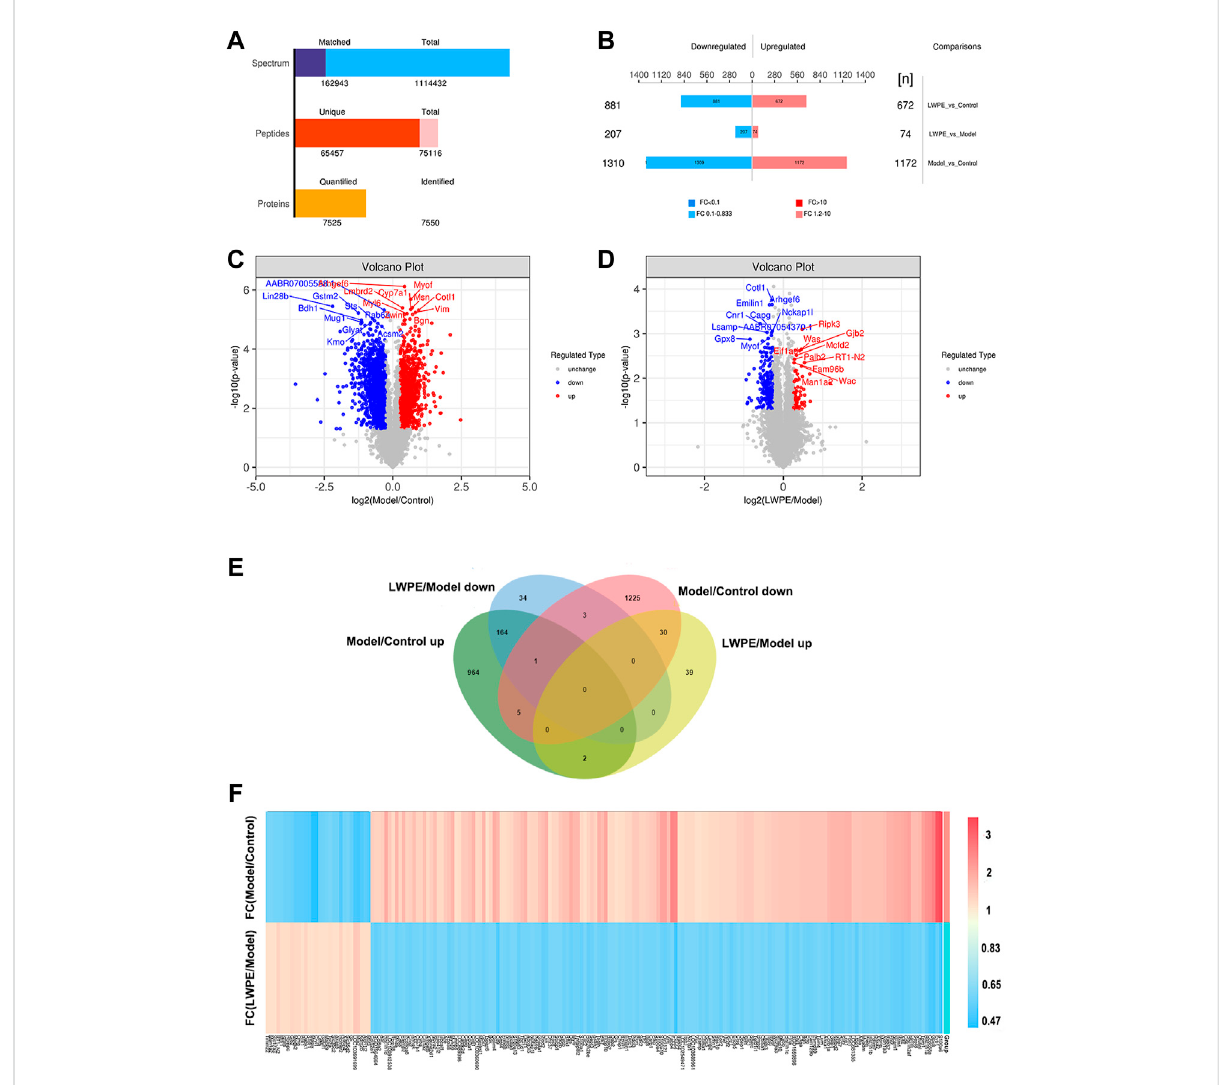
FIGURE 5 Identi fi cationofdifferentiallyexpressedproteins(DEPs)intheliversofcontrol,modelandLWPEtreatedrats. (A) BasicstatisticsoftheMSresults ofthesamples. (B) ThenumberofDEPsindifferentcomparisongroups. (C and D) VolcanoplotsofDEPsindifferentcomparisongroups.Thereddots indicate upregulated proteins and the blue points show downregulated proteins screened based on fold change (FC) > 1.2 or < 1/1.2 and a corrected p -value of < 0.05. (E) Venn diagrams showing the distribution of overlapping proteins. (F) Hierarchical cluster analysis of 195 DEPs. The color indicates fold changes of proteins, dark blue indicates a decrease, while red indicates an